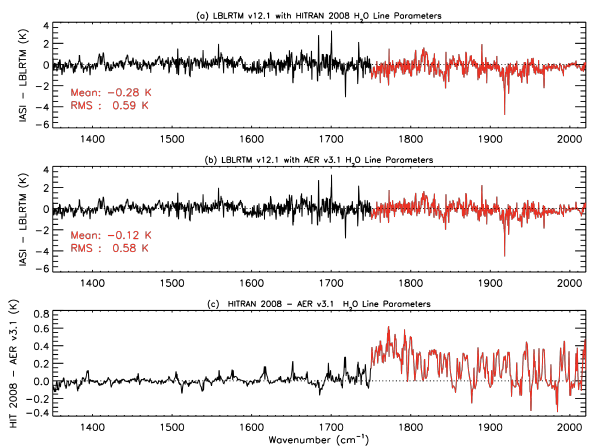
Fig. 19. (a) Brightness temperature residuals for an example profile with 1.5cm PWV after the H 2 O P- and R-branch retrieval when the HITRAN 2008 H 2 O line parameters are used in LBLRTM v12.1. (b) Same as (a) but for the AER v3.1 line parameters used in LBLRTM v12.1 in the rest of this study. (c) Difference between (b) and (a) , showing the discontinuity at wavenumbers greater than ∼ 1750cm − 1 , where HITRAN 2008 does not use the Coudert et al. (2008) line positions and intensities included in AER